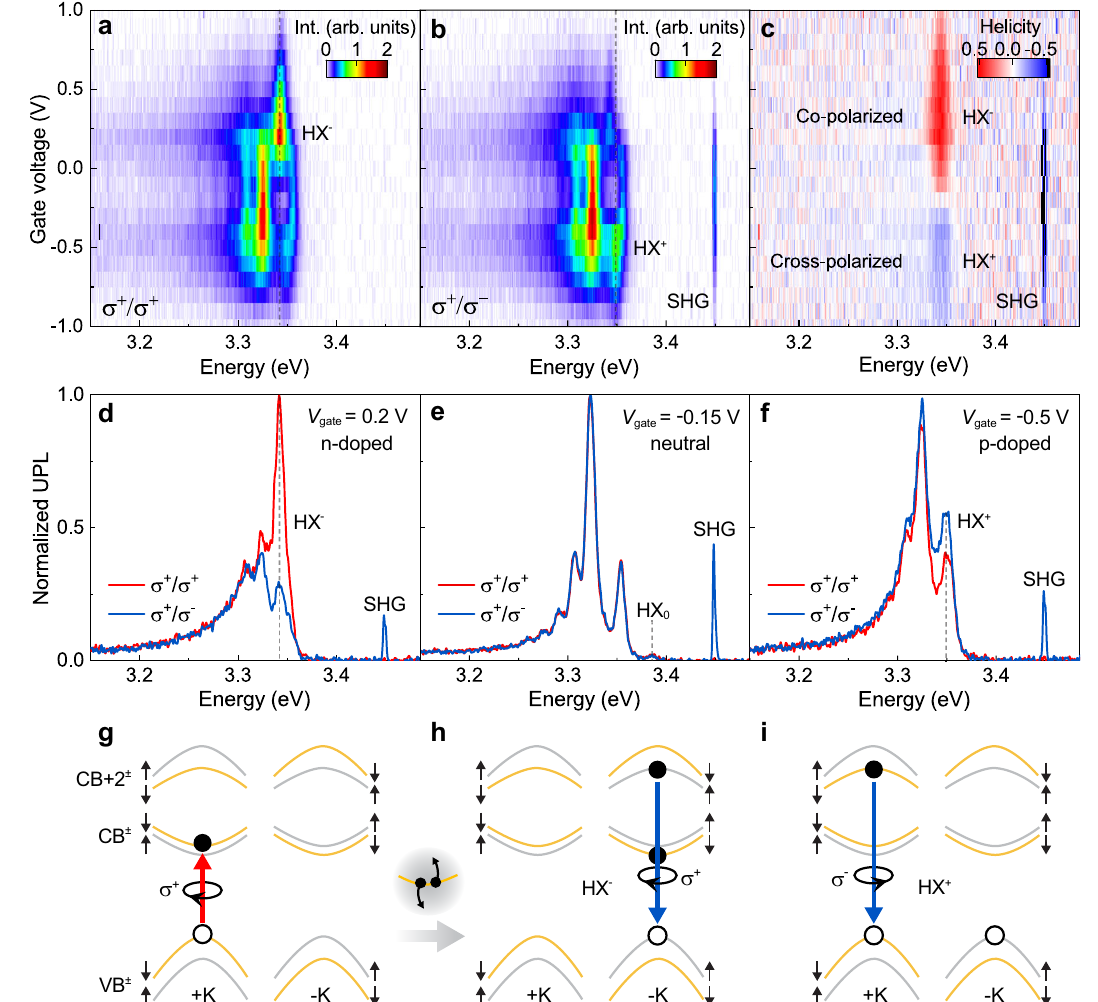
Fig. 2 | Valley polarization and helicity of the high-lying trion in UPL from monolayer WSe 2 . a , b Gate-voltage dependence of co-polarized ( a ) and cross- polarized ( b ) UPL under left-hand circularly polarized excitation. c Helicity of the UPL as a function of gate voltage. d – f Polarization resolved UPL spectra at gate voltagesof0.2V( d ), − 0.15V( e ),and − 0.5V( f ). g Illustrationofresonantpumpingof theAexcitoninthe+Kvalleywitha σ + circularlypolarizedCWlaser.Thisexcitation